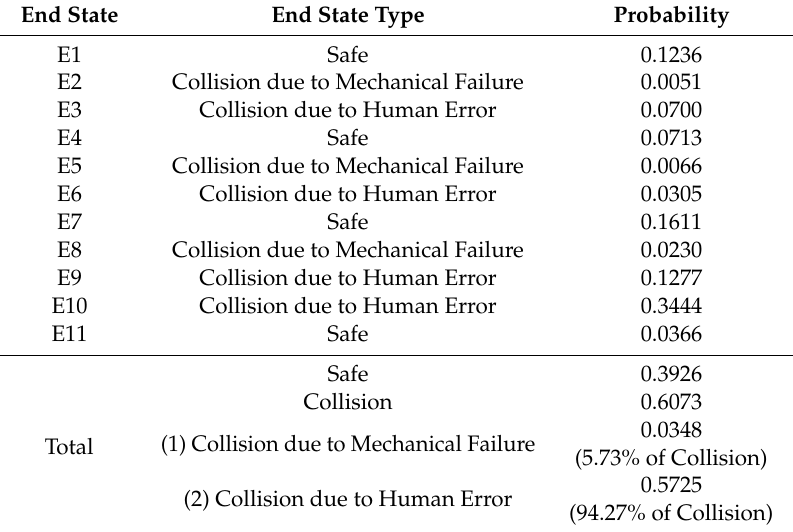
Table 3. Probability Values of All End State